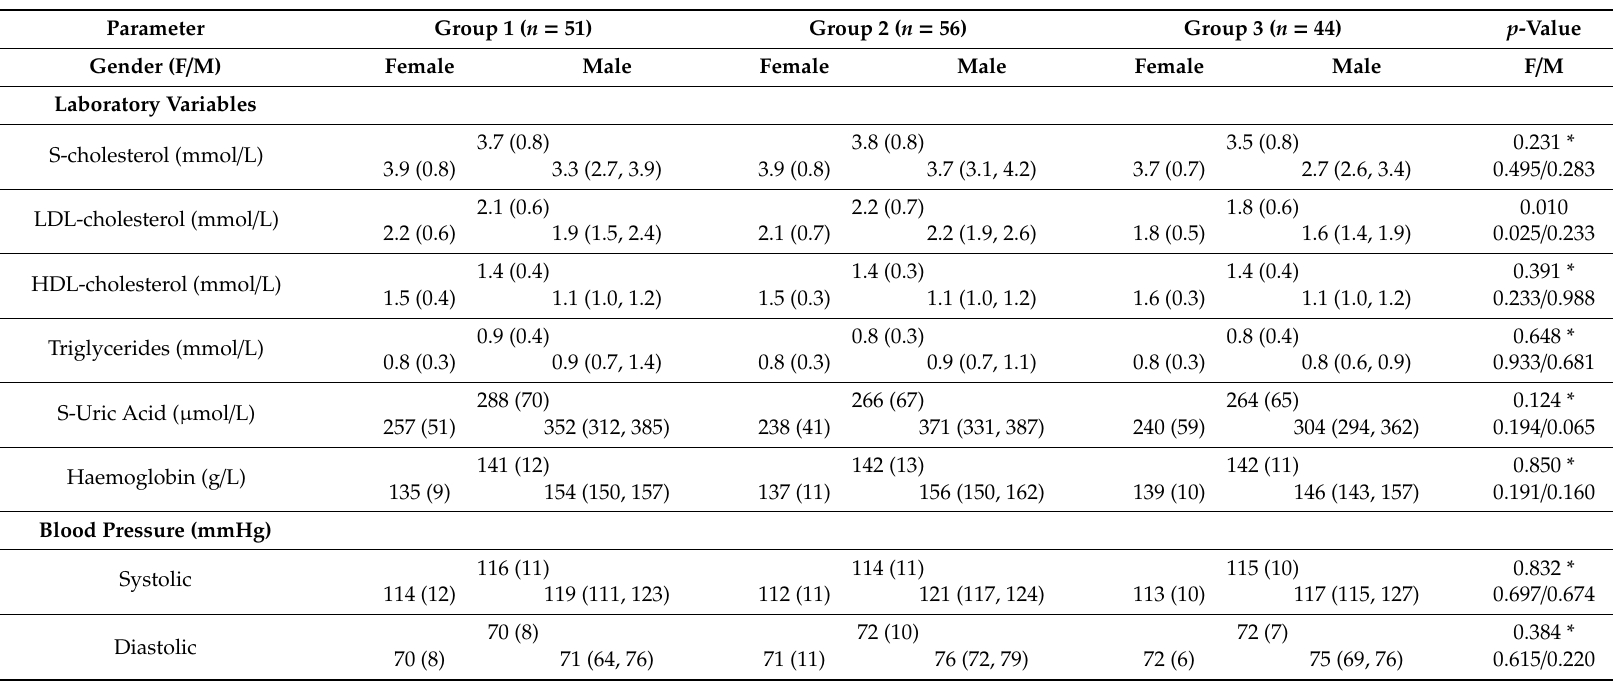
Table 5. Cardiovascular health (lipids and BP) and safety marker status (serum UA and haemoglobin) according to the time in WFPB lifestyle program: short (0.5– < 2 years), medium (2– < 5 years) and long-term (5–10 years) (groups 1, 2 and 3), and by